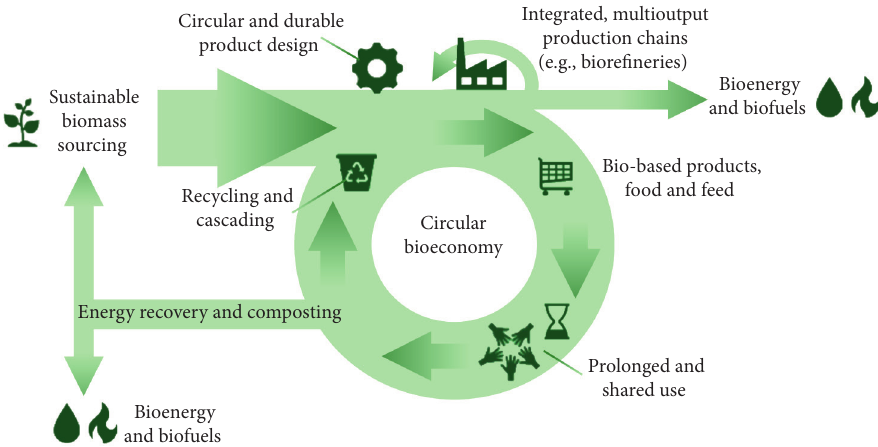
Figure 2: Circular bioeconomy and its elements in relation to deadwood resources. Source: Stegmann et al.